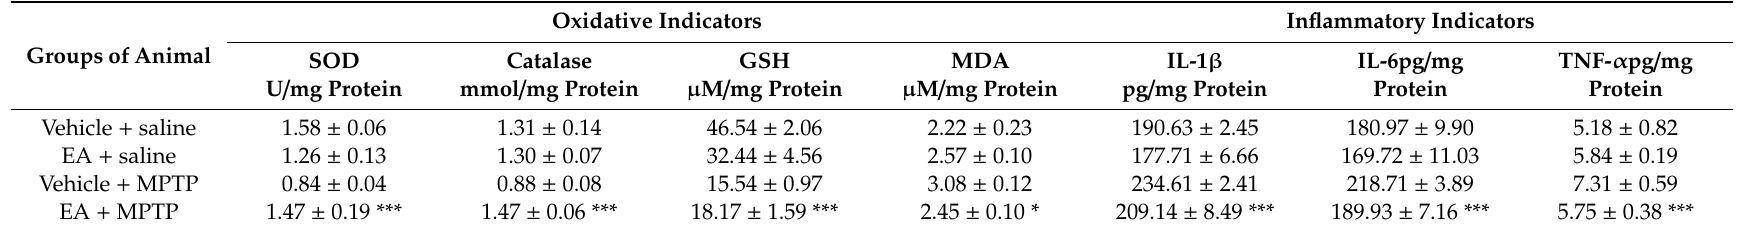
Table 1. Oxidative and inflammatory indicators of di ff erent experimental